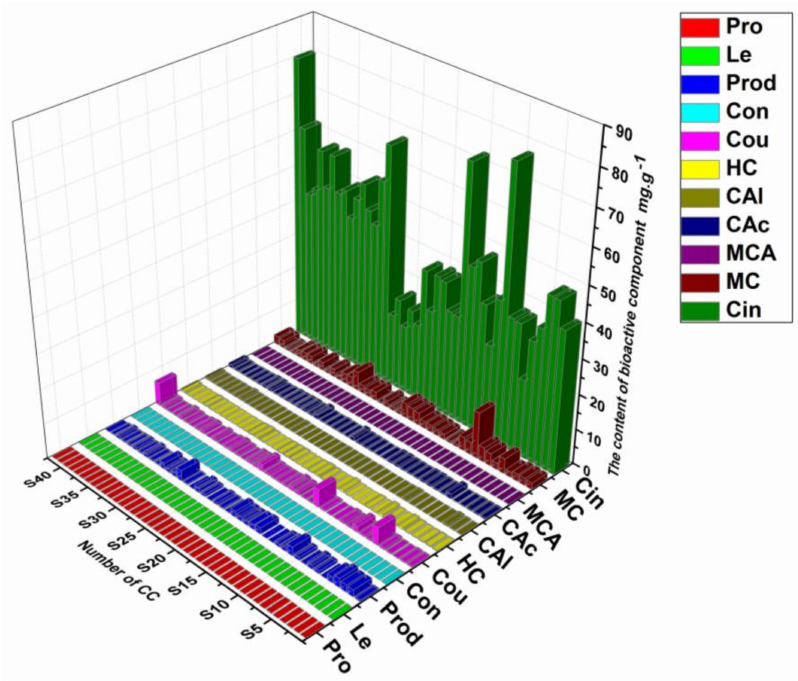
Figure 5. Quantitative analysis of the 11 constituents of 42 batches of CC (n =